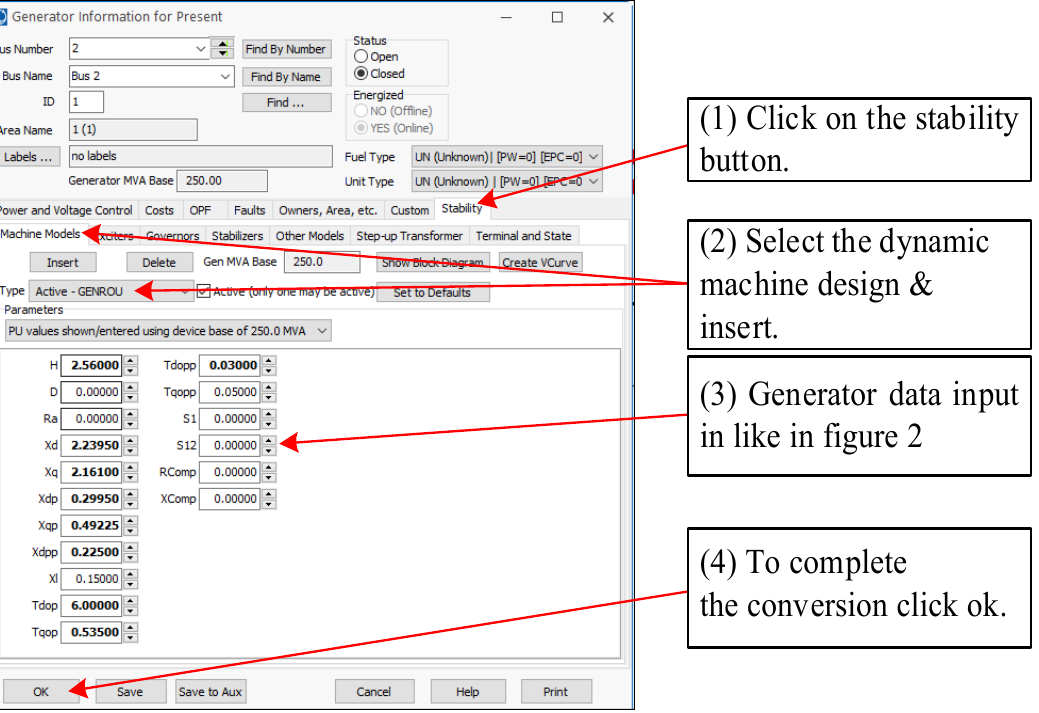
Figure 5. Alteration of the model of load flow to transient constancy design .